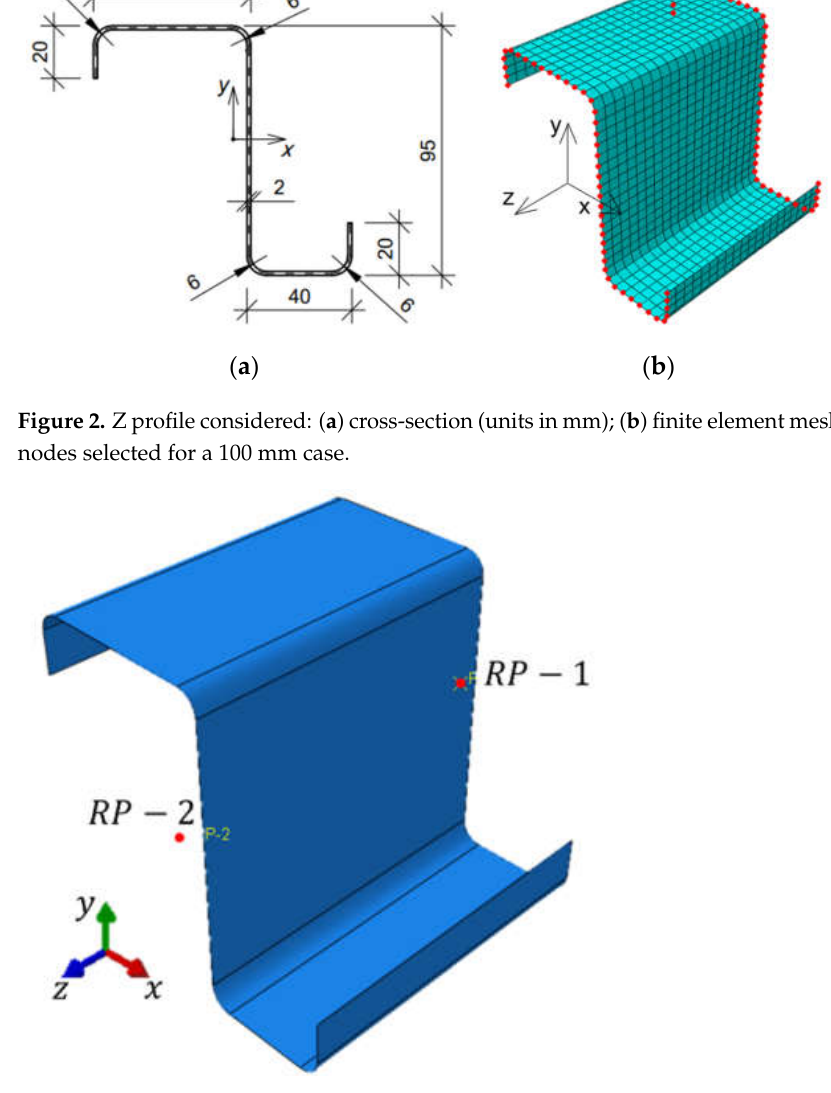
Figure 2. Z profile considered: ( a ) cross-section (units in mm); ( b ) finite element mesh with con- densed nodes selected for a 100 mm case.